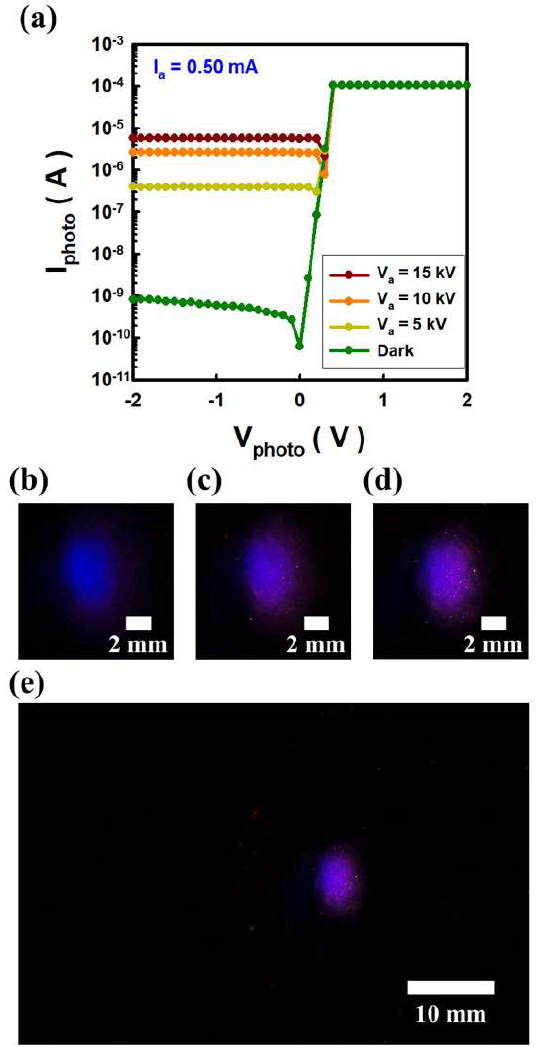
Figure 3. Extreme ultraviolet lighting of Sn target excited by cold cathode electrons irradiation. ( a ) Photocurrent response of EUV lighting through photodiode (SXUV100, OPTO DIODE) measure- ment. ( b ), ( c ), and ( d ) are optical images when the anode current of 0.5 mA is fixed and the anode voltage is 5, 10, and 15 kV, respectively. ( e ) is a reduced-magnification image when the anode volt- age is 15 kV.